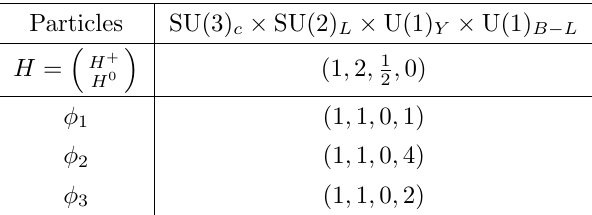
Table 2 . Scalar (cid:12)elds and their corresponding charges under all the symmetry groups. scalar (cid:12)elds (including the SM ones) of the present model and their charges under